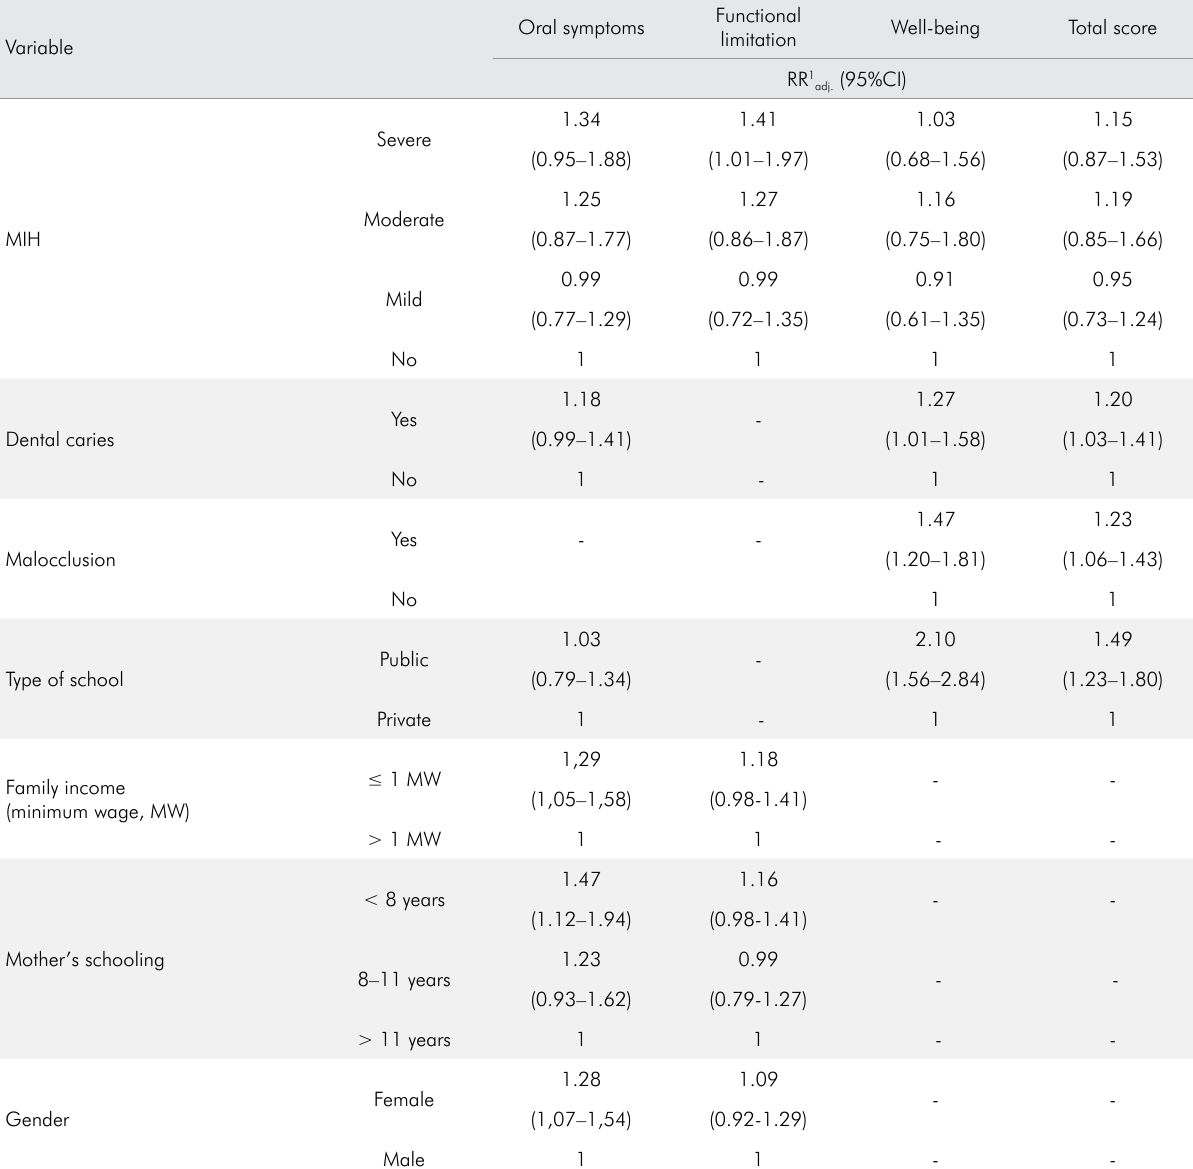
Table 2. Association between scores of the P-CPQ questionnaire with MIH and confounding variables: final multivariate model (n =